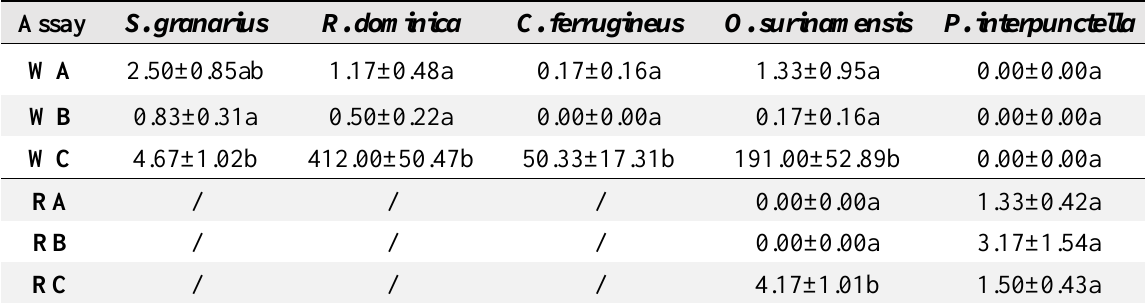
Table 1. The mean number±SE of emerged adult insect pests developed on three different mechanical states (A, B, C) of wheat (W) and rye (R) kernels. Assay S. granarius WA WB 0.83±0.31a